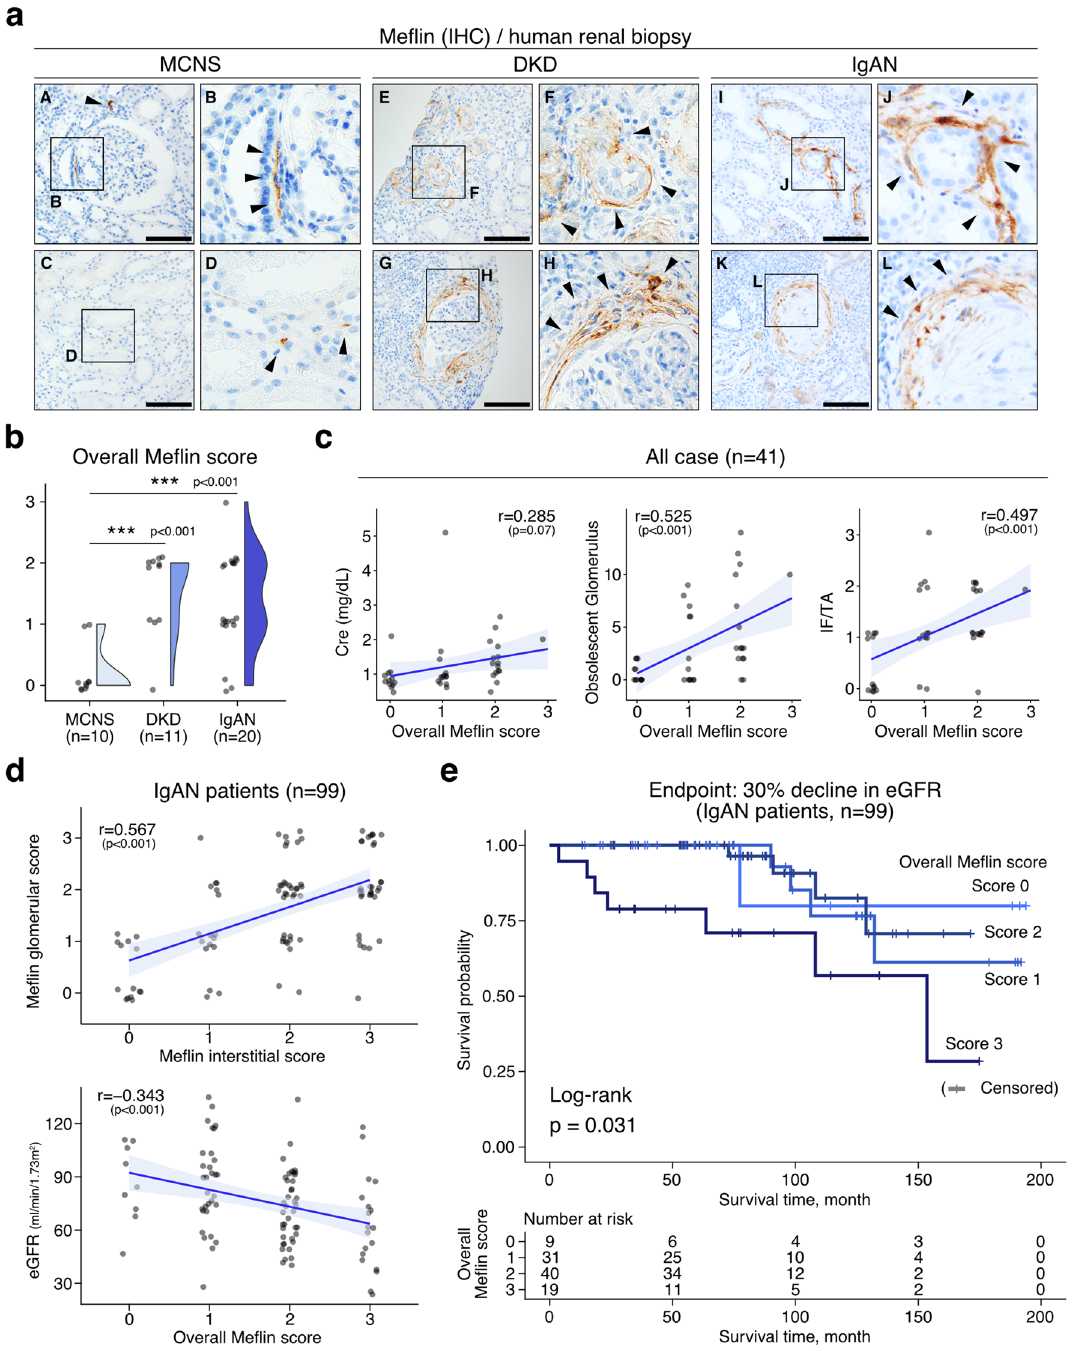
Figure 6. Meflin expression is correlated with poor renal prognosis in patients with chronic kidney diseases. ( a ) Representative Meflin IHC using kidney biopsy samples from patients with MCNS, DKD, and IgAN. Arrowheads indicate Meflin + areas. Scale bar, 50 µm. ( b ) Raincloud plots showing overall Meflin scores in the indicated groups. *** p < 0.001 (one-way ANOVA followed by Tukey’s test). ( c ) Correlations between overall Meflin score and serum Cre, obsolescent glomerulus counts, and IF/TA in all cases of MCNS, DKD, and IgAN ( n = 41) were analyzed using Pearson’s correlation coefficient. ( d ) Biopsy samples from patients with IgAN ( n = 99) were analyzed for associations between Meflin glomerular score and Meflin interstitial score (upper panel) and overall Meflin score and eGFR (lower panel), followed by correlation testing using Pearson’s correlation coefficient. ( e ) Kaplan–Meier survival analysis; patients with IgAN and high overall Meflin scores exhibited poor renal prognosis (a 30% decline in eGFR was used as the end point) compared with those with low overall Meflin scores. Log-rank test was used for statistical analysis. Data were analyzed and visualized using R software 47 in ( b–e